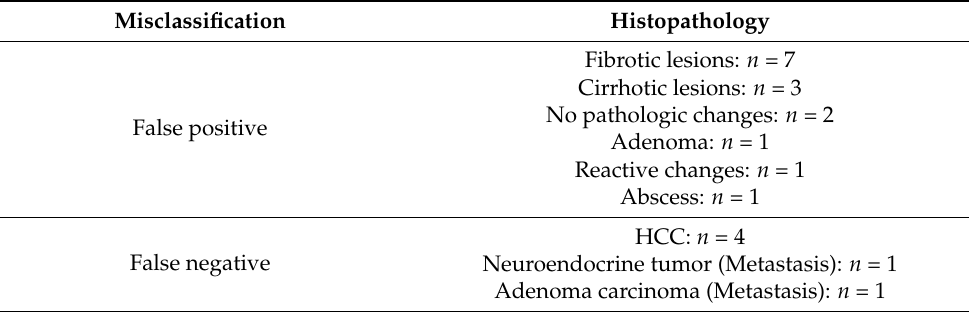
Table 3. Misclassifications of CEUS in comparison to the histopathological